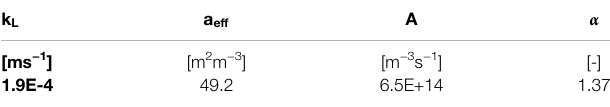
TABLE 2 | The four estimated model parameters are listed